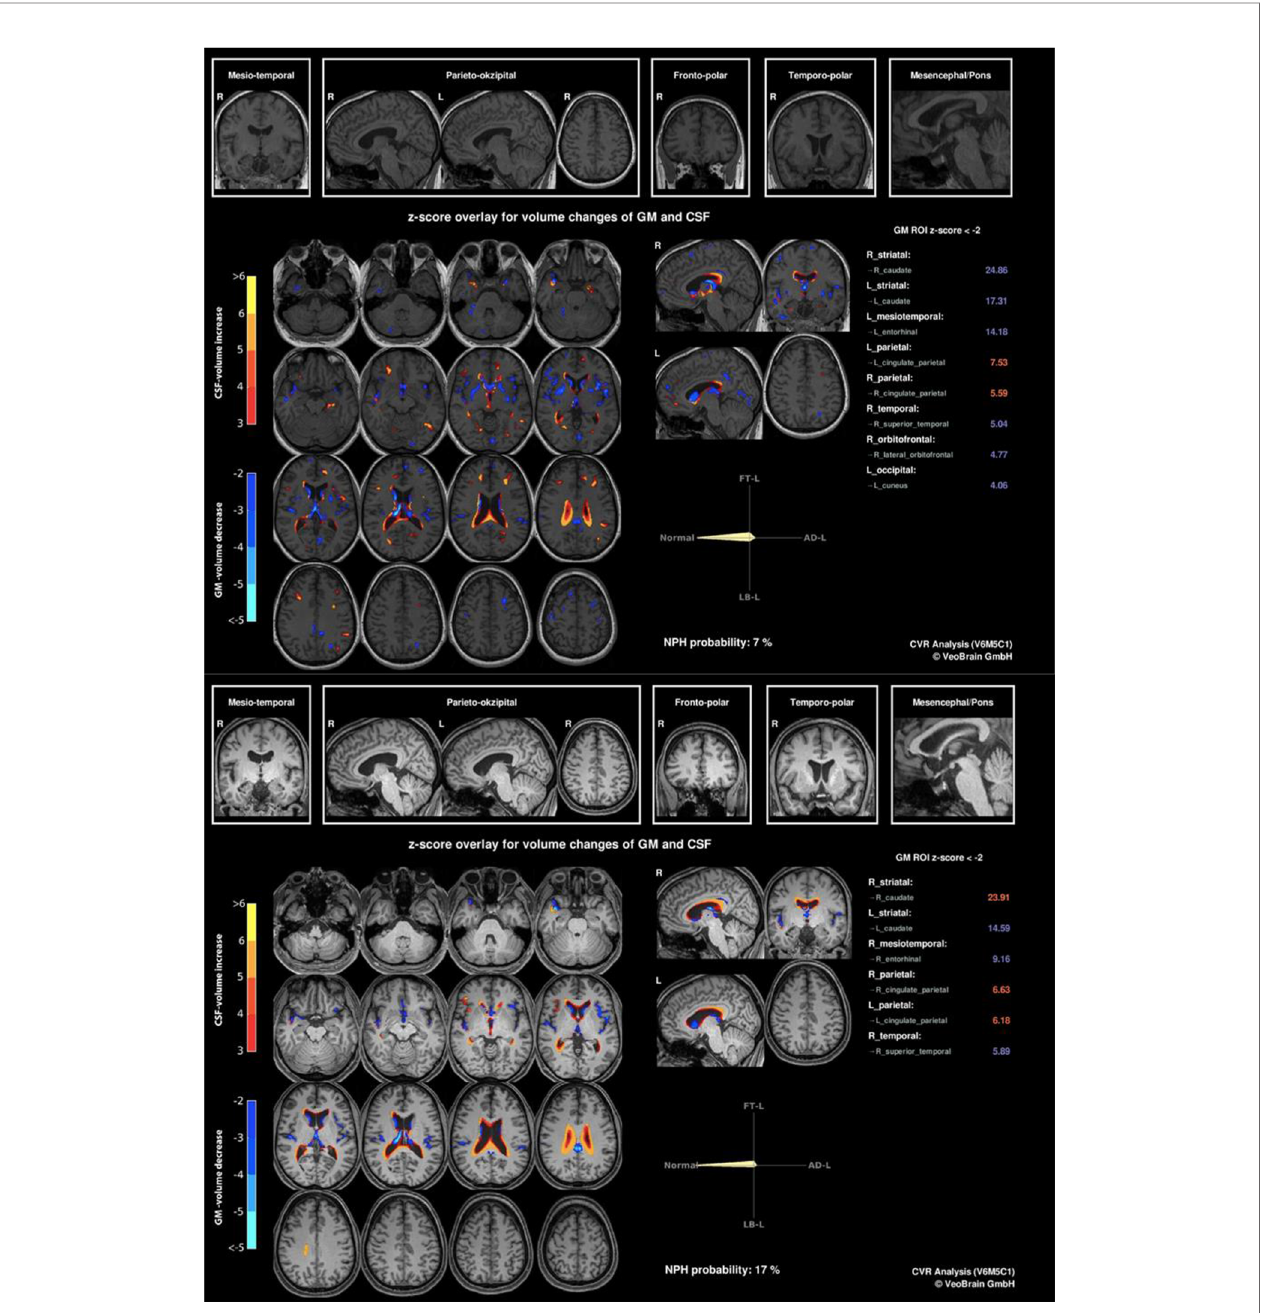
FIGURE 2 | Initial (2010, at the top) and follow-up (2019, at the bottom) magnet resonance imaging fi ndings with combined volume- and region-based analysis method (CVR) revealed an enlargement of the lateral ventricles with emphasis on the posterior horns and slight striatal and insular atrophy. There was no relevant change in fi ndings between 2010 and 2019